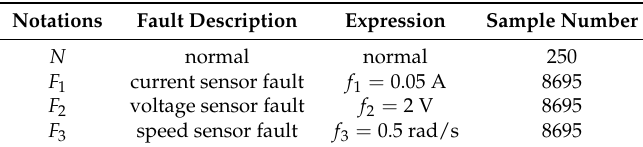
Table 2. The parameters for concerned states.